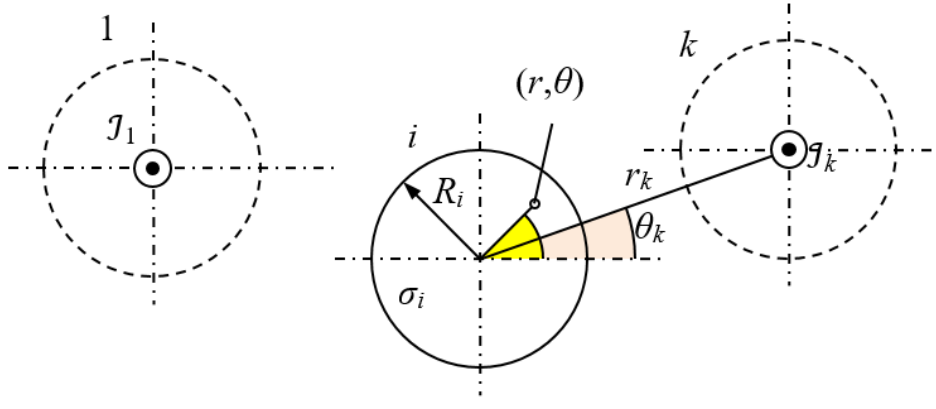
Figure 2. Approximate approach to the proximity effect in multi-wire bus duct with round wires.